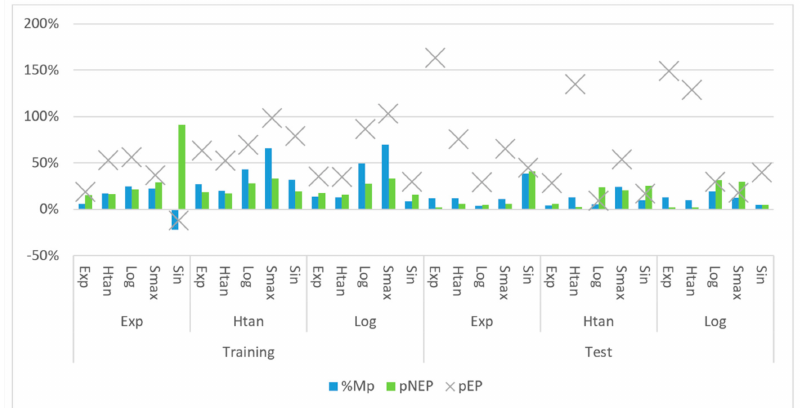
Figure 8. List for the best neural networks in accordance with the maximisation of pNEP indicator. Note: The number of neurons in the hidden layer ranged from 5 to